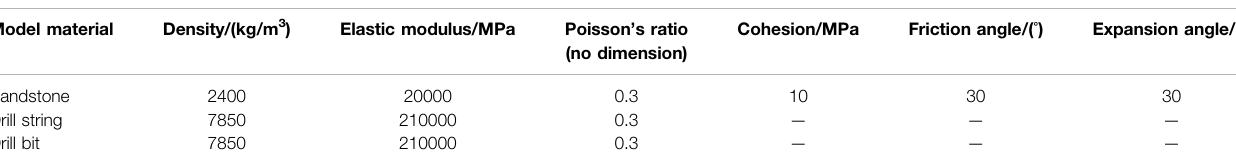
TABLE 1 | Parameters of model